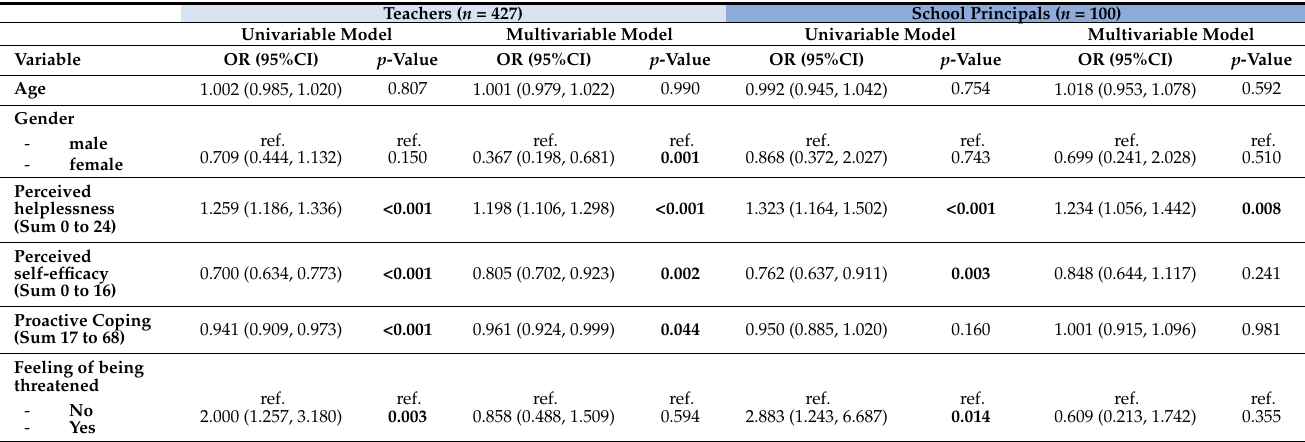
Table 7. Simple Logistic Regression (Dependent Variable ‘considered leaving the